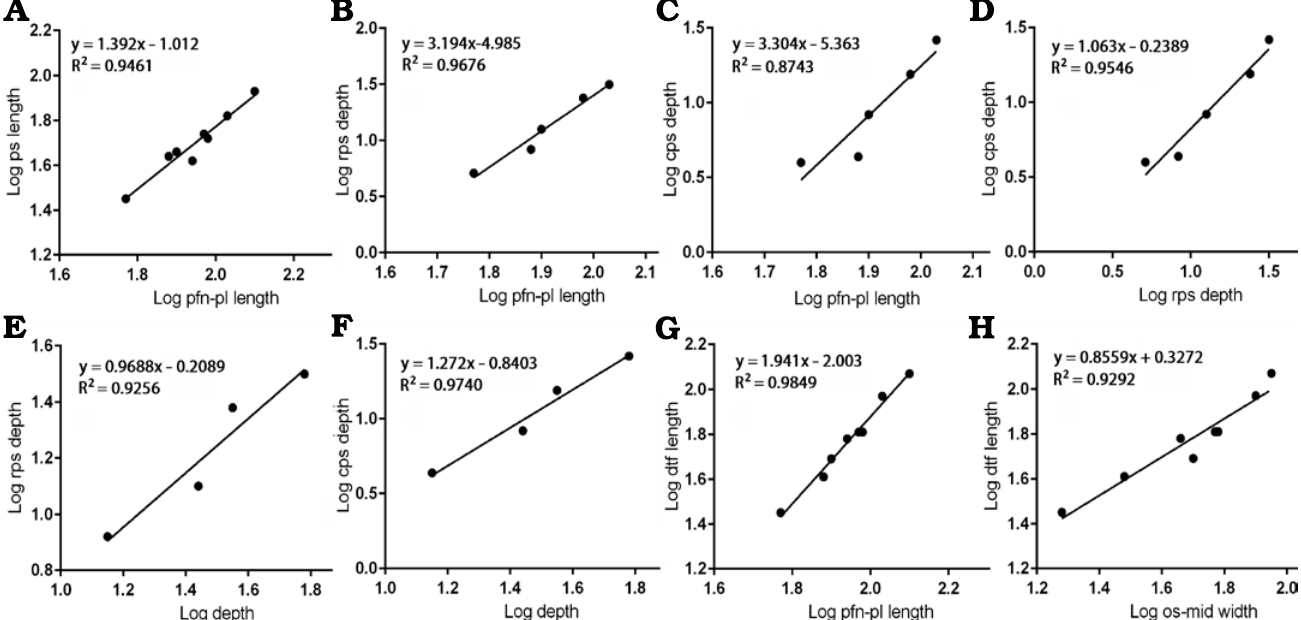
Fig. 5. Bivariate allometric results of different parts of Tarbosaurus bataar frontals. A . Length of the frontal between prefrontonasal process and the fron- toparietal suture (pfn-pl length, 4) and the length of the postorbital suture (ps length, 10). B . Length of the frontal between prefrontonasal process and the frontoparietal suture (4) and the depth of the anterior part of the postorbital suture (rps depth, 11). C . Length of the frontal between prefrontonasal process and the frontoparietal suture (4) and the depth of the posterior part of the postorbital suture (cps depth, 12). D . Depth of the anterior part of the postorbital suture (11) and the depth of the posterior part of the postorbital suture (12). E . Depth of the frontal at the region that is immediately anterior to the most anterior point of the sagittal crest (depth, 9) and the depth of the anterior part of the postorbital suture (11). F . Depth of the frontal at the region that is im- mediately anterior to the most anterior point of the sagittal crest (9) and the depth of the posterior part of the postorbital suture (12). G . Length of the frontal between prefrontonasal process and the frontoparietal suture (4) and the length of the dorsotemporal fossa (dtf length, 7). H . Width of the frontal between medial edge of the orbital slot and the midline (os-mid width, 5) and the length of the dorsotemporal fossa